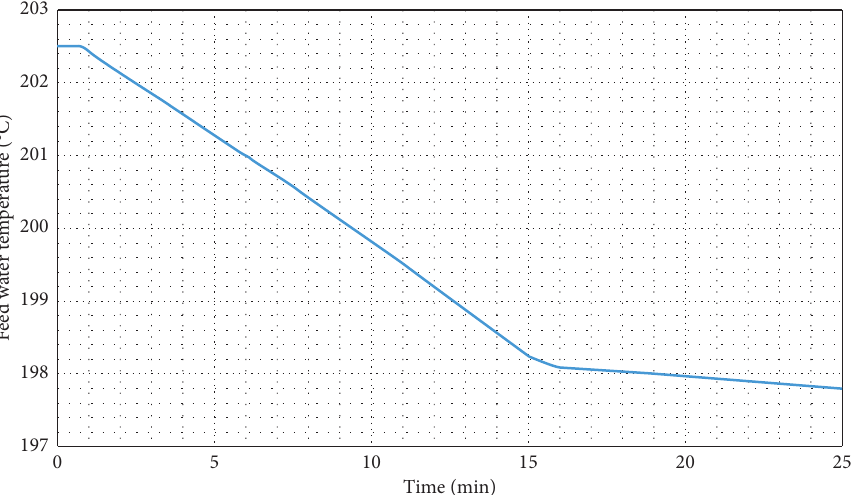
Figure 12: Feedwater temperature in case 1.